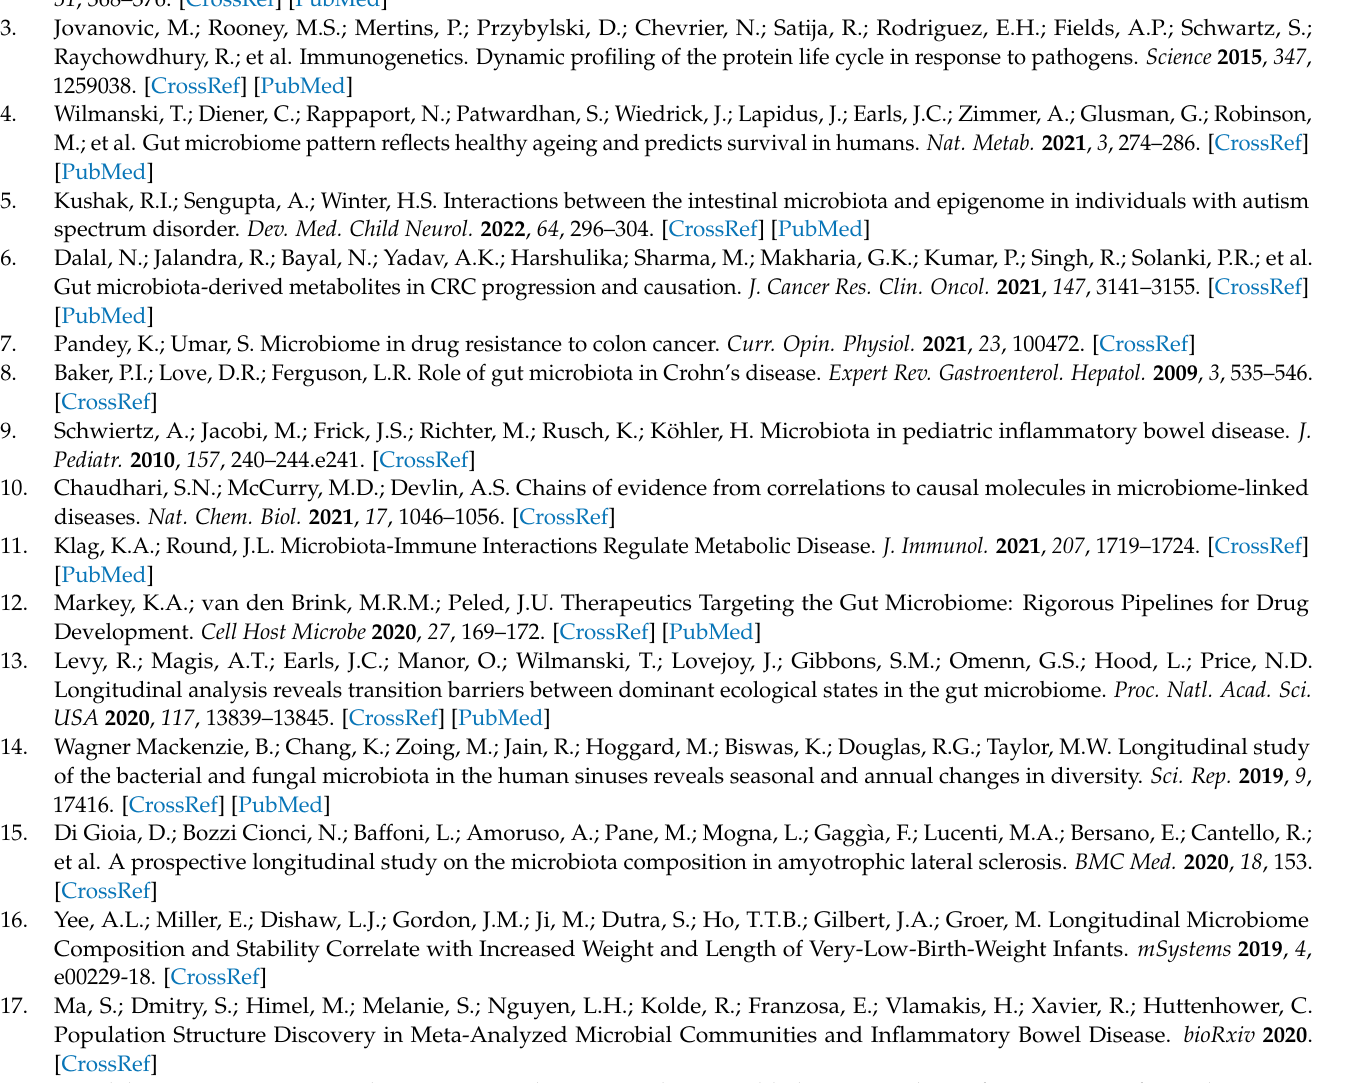
ple profile information; Table S2: FE (Functional Enrichment) and TSEA (Taxonomy-Set Enrichment Analyses); Video S1: Movies for 3D PCA of 5 different batch handling